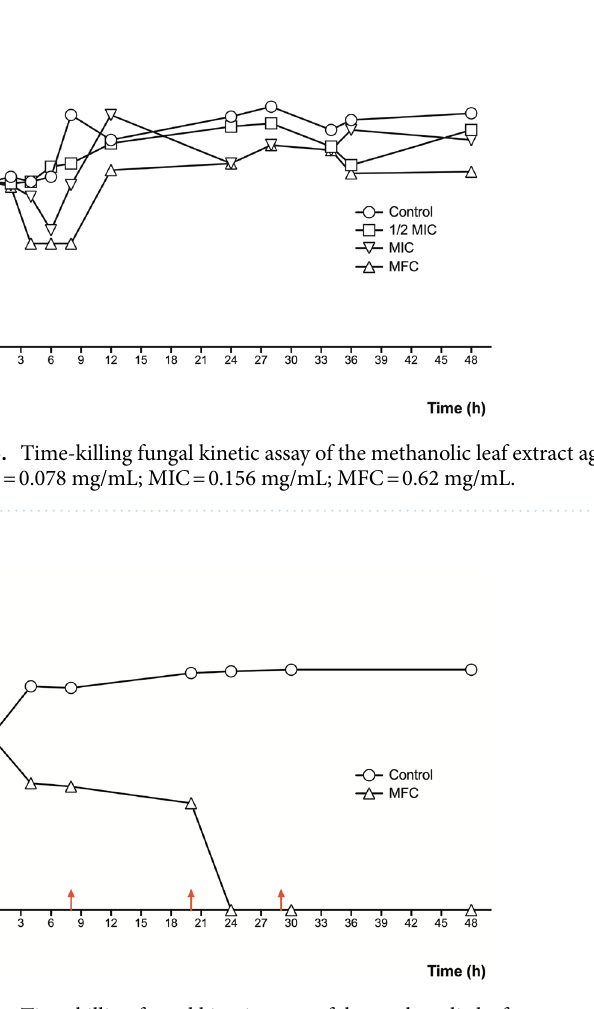
Figure 6. Time-killing fungal kinetic assay of the methanolic leaf extract against the C. tropicalis clinical case. MFC = 1.24 mg/mL. Red lines indicate the times when the extract was added to the